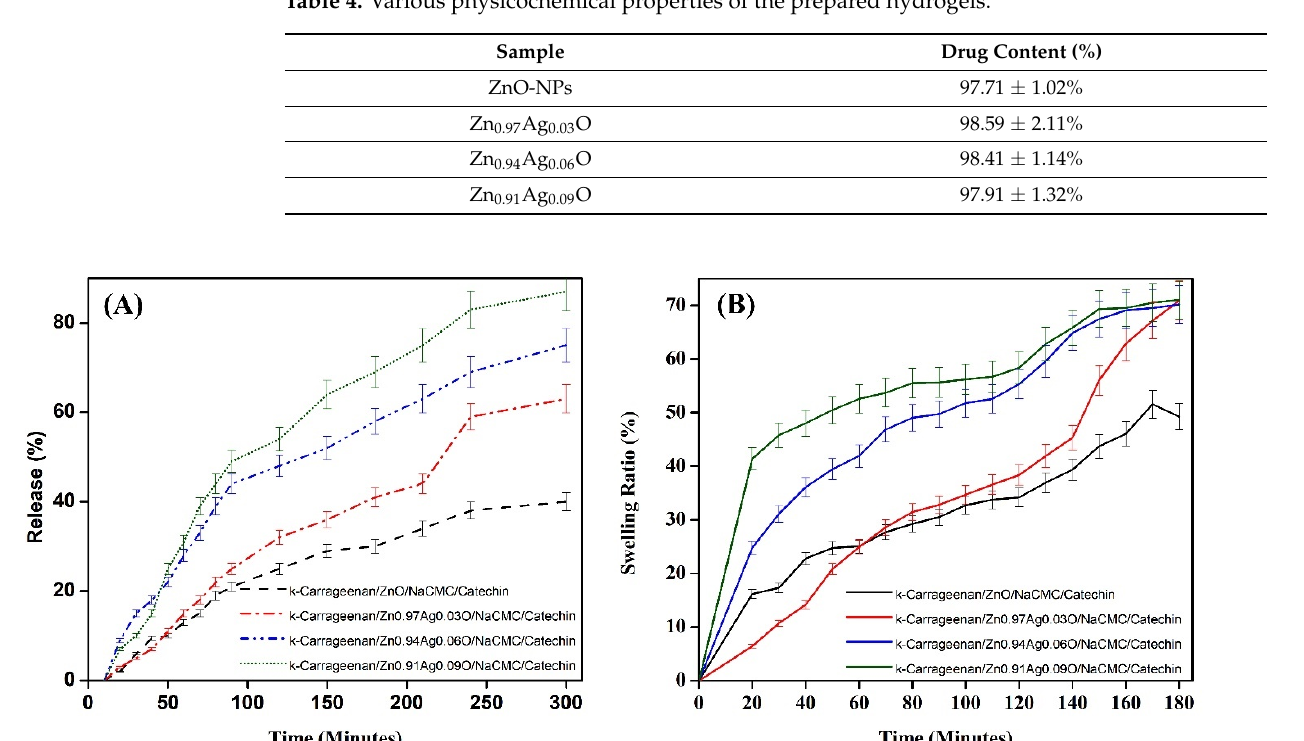
Table 4. Various physicochemical properties of the prepared hydrogels.